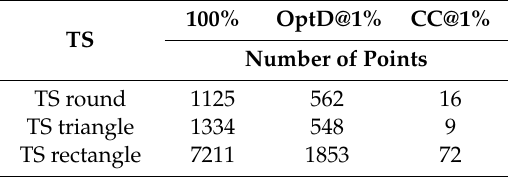
Table 6. E ff ect of data reduction on TS points.